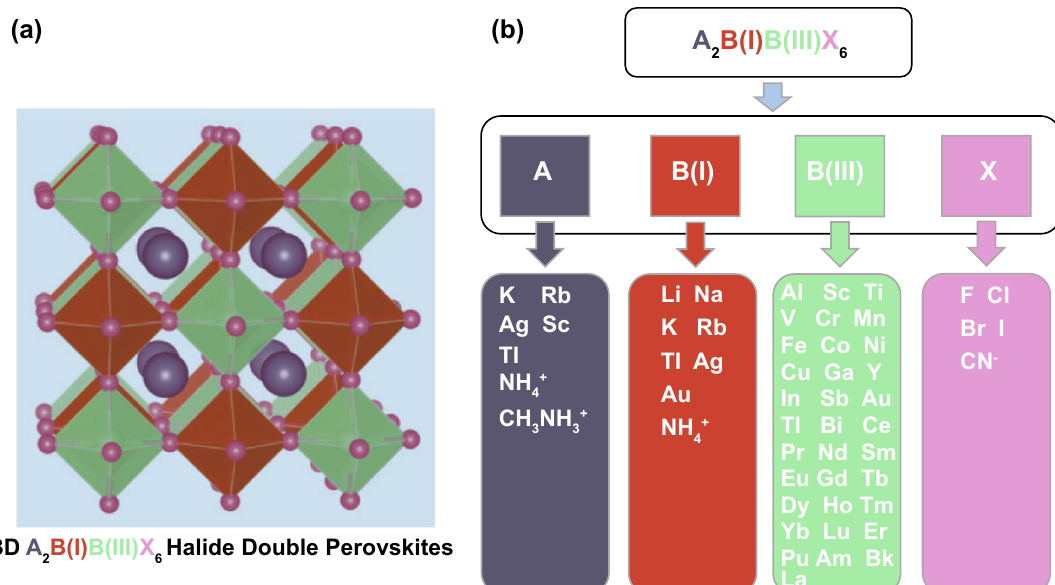
Fig. 15 Crystal structure of double perovskite A 2 B(I)B(III)X 6 ( a ) and the elements/functional groups that can form double perovskite A 2 B(I)